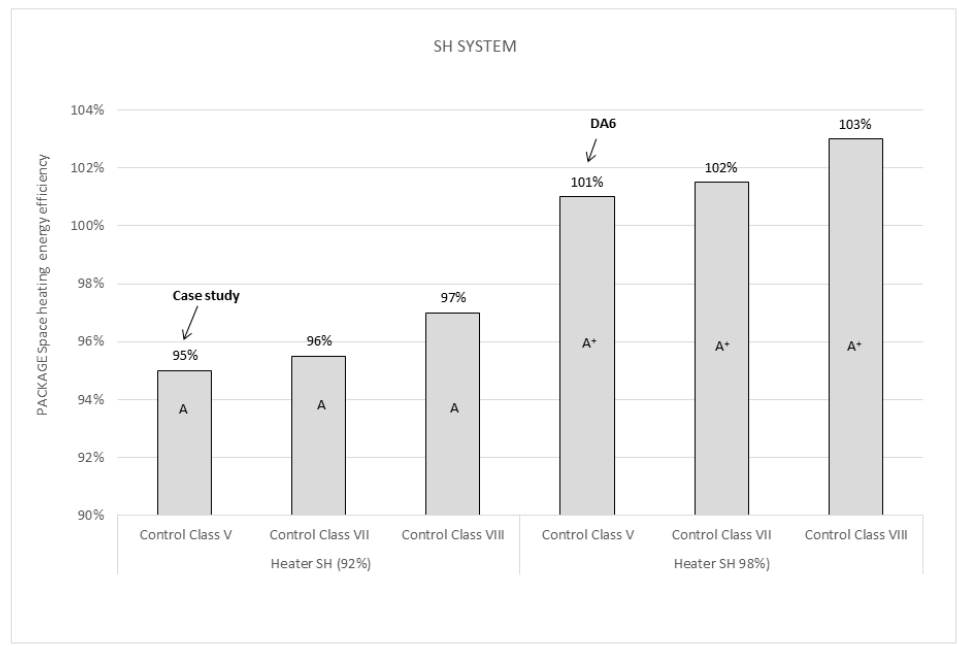
Figure 9. The Influence of the heater and the controls on the space heating system.